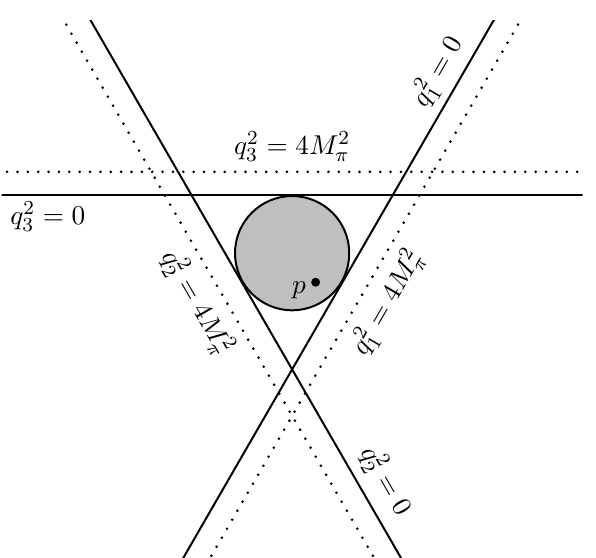
(b) Mandelstam diagram for the selected kinematics of point p . The double-spectral regions for the pion box are shown. Lines of (cid:12)xed s , t , and u running through the point p with ( s; t; u ) = ( q 2 are shown. They do not intersect any double-spectral region. Figure 10. For ( g 2) (cid:22) kinematics, the paths of the single-variable dispersion integrals never enter (cid:0) any double-spectral region, which enables a partial-wave expansion.